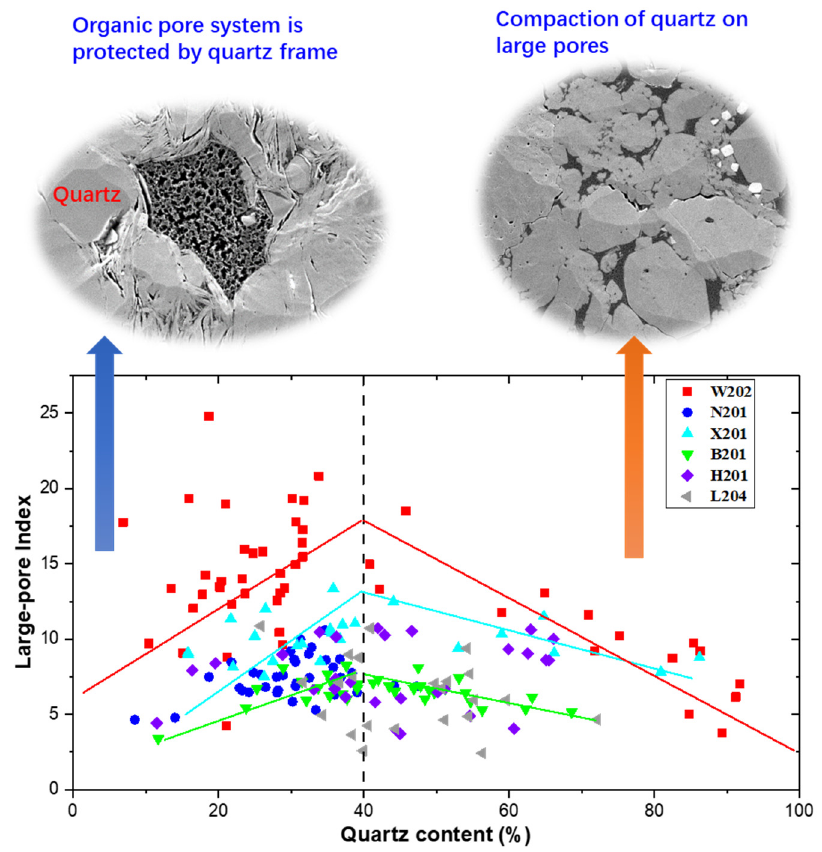
Figure 18. The correlation between the large pore index and the quartz